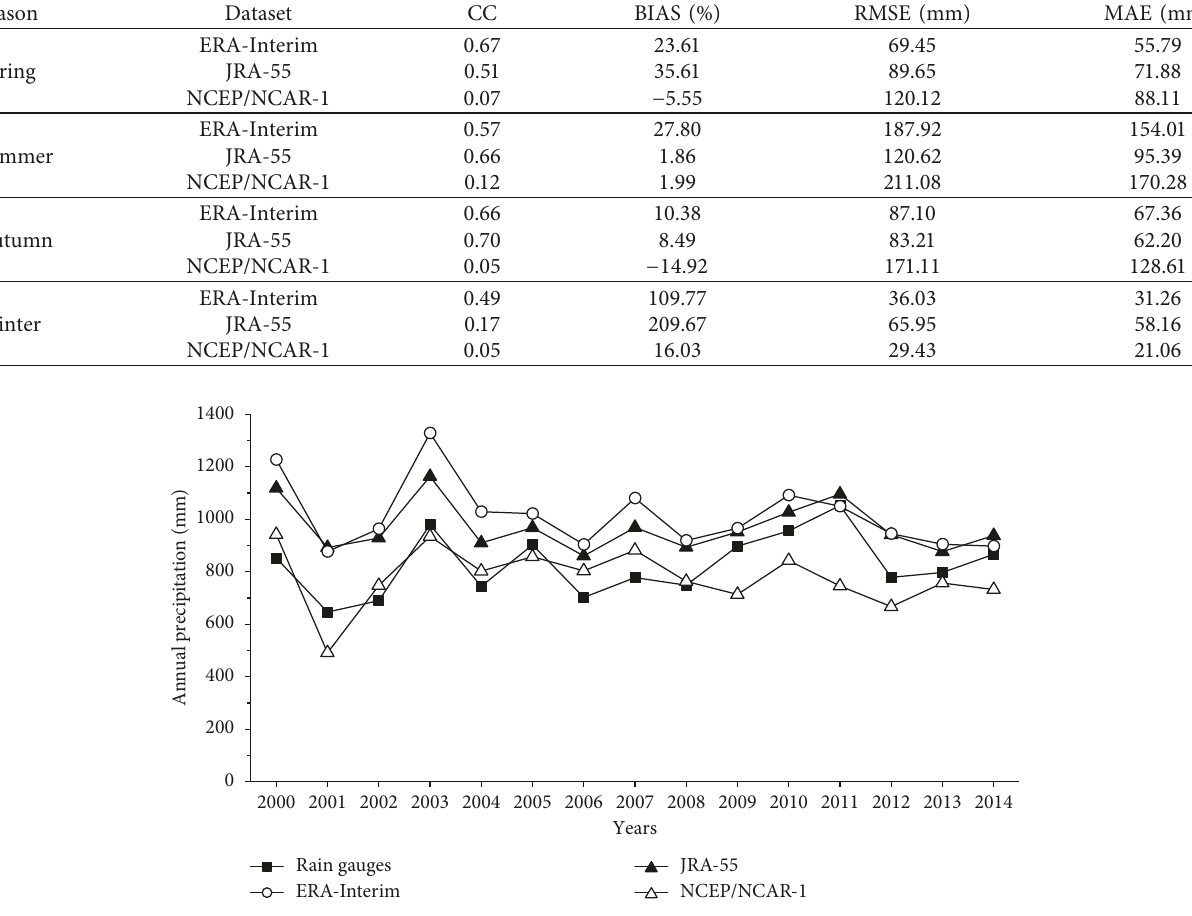
Figure 6: The line chart of regional average annual precipitation from rain gauges and the three reanalysis datasets. Table 4: CC, BIAS, RMSE, and MAE between three reanalysis precipitation datasets and gauged rainfall at annual scale over the Qinling-Daba Mountains, China (all products passed the signifi- cance test at the 99% confidence